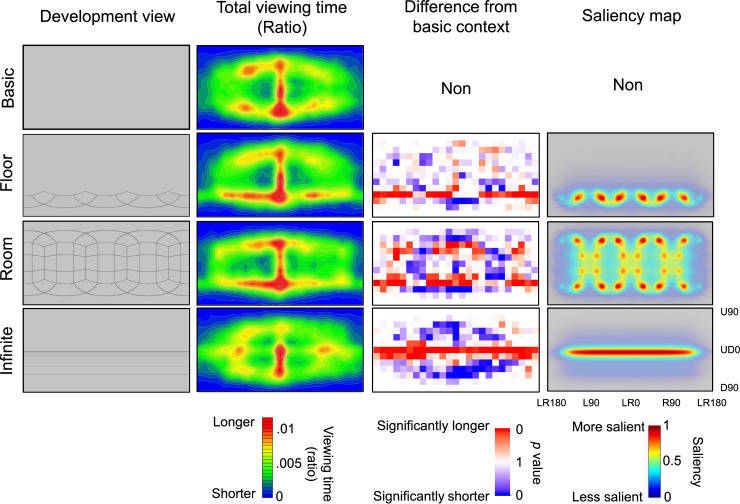
Effect of 360-degree spatial context on total viewing times.In the ratio of total viewing times, redder areas indicate longer viewing times, and more purple areas indicate shorter viewing times. The difference from the basic context shows p values obtained from multiple comparisons. The color becomes redder as the viewing time in a context was longer than in the basic context, while the color becomes bluer as the time was shorter than that in the basic context. The saliency map was created using the graph-based visual saliency technique.